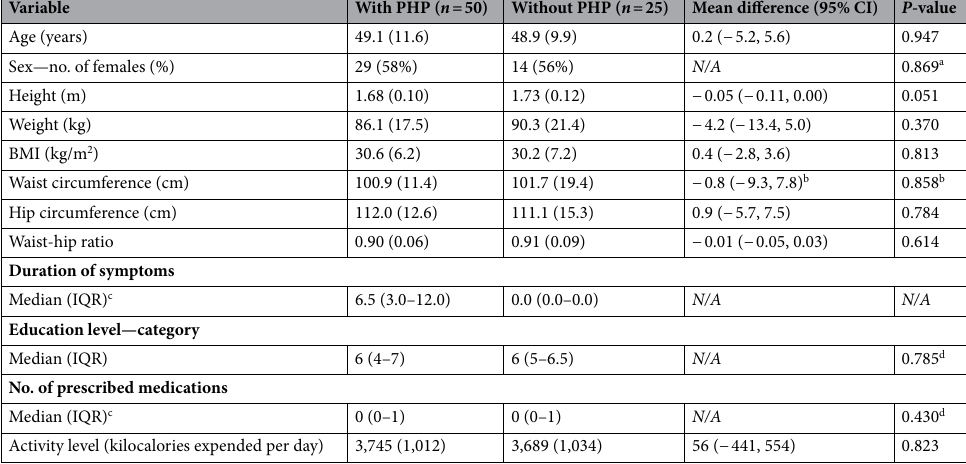
Table 1. Participant characteristics—values are means (SDs) unless otherwise stated. N/A = Not applicable. a P -value relates to Chi-squared test. b Mean difference, 95% CIs and p -value adjusted as Levene’s Test for Equality of Variances was significant ( p < 0.05). c Median (IQR) reported as variable not normally distributed. d P -value relates to Mann–Whitney U test.